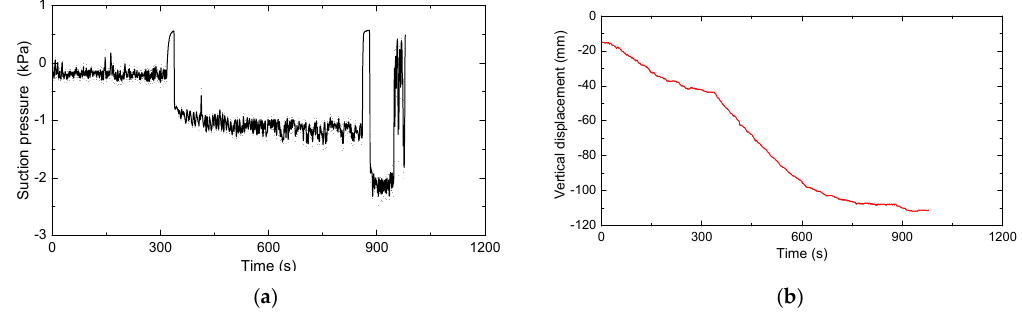
Figure 6. Variations in suction and displacement with time in PS1-1. ( a ) Relationship between suction and time; ( b ) Relation between displacement and time. Figure 7. Variations in suction and displacement with time in PS1-2. ( a ) Relationship between suction and time; ( b ) Relationship between displacement and time.